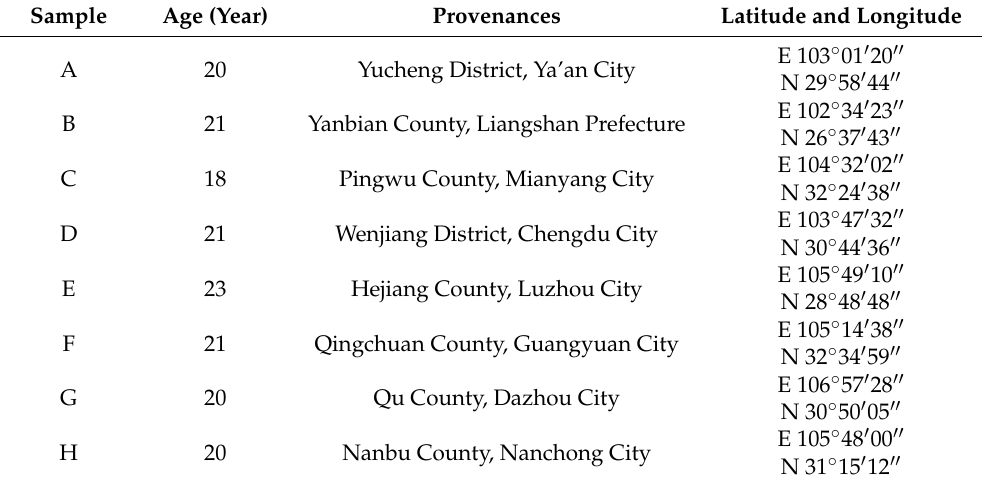
Table 1. Information on different Alnus cremastogyne collection sites.